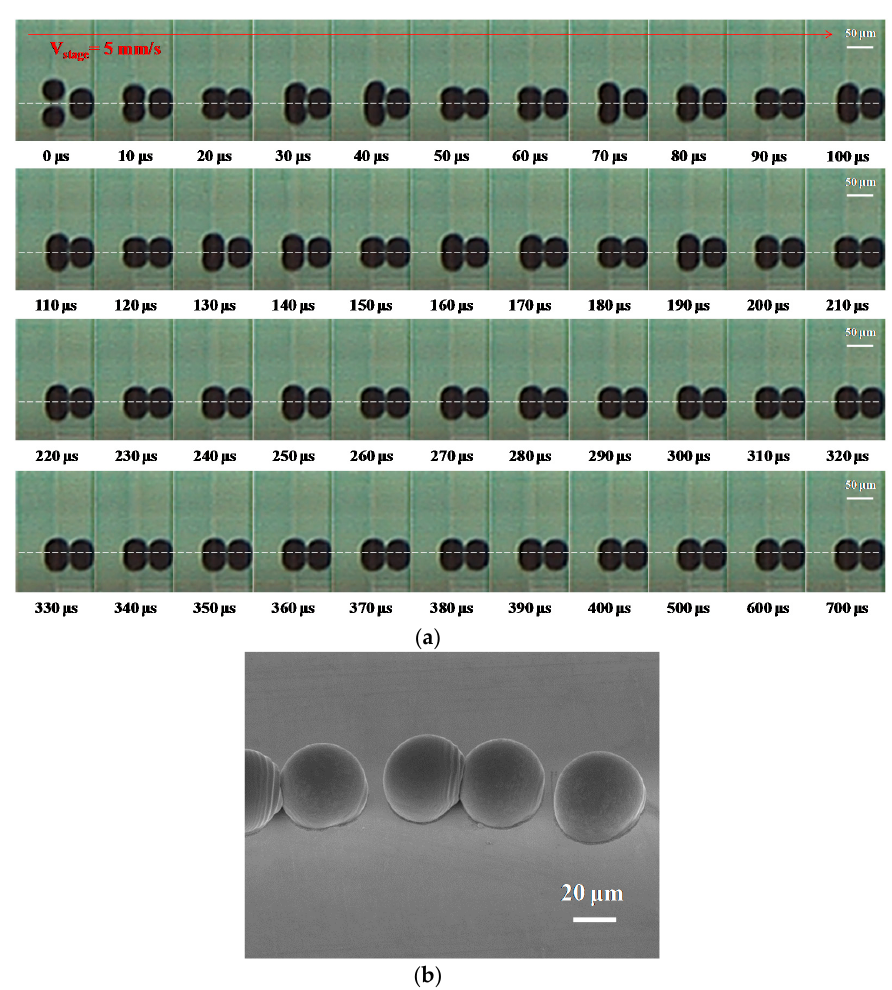
Figure 4. The deposition of molten metal droplets under a dot-spacing of 50 μ m with the following initial characteristics: diameter D 0 = 50 μ m, velocity = 1.1 m ∙ s − 1 , stage velocity = 5 mm ∙ s − 1 (frequency = 100 Hz) and sample temperature 30 °C (Stefan number Ste = 0.722). ( a ) Evolution of droplet